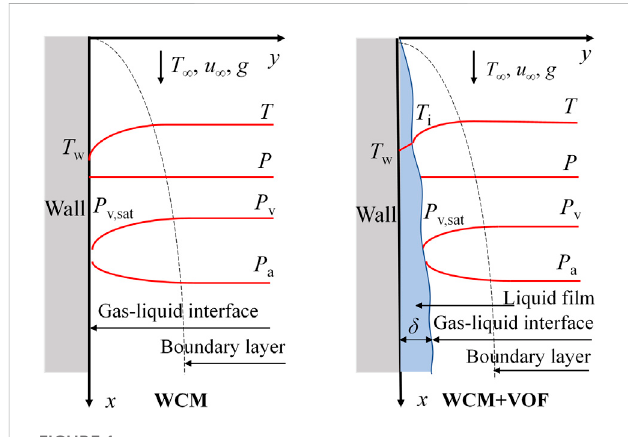
FIGURE 1 Condensationofthesteam-airmixture fl owingalonganisothermal vertical plate: (left) simpli fi ed model (adapted from Zschaeck et al., 2014); (right) the model used in this